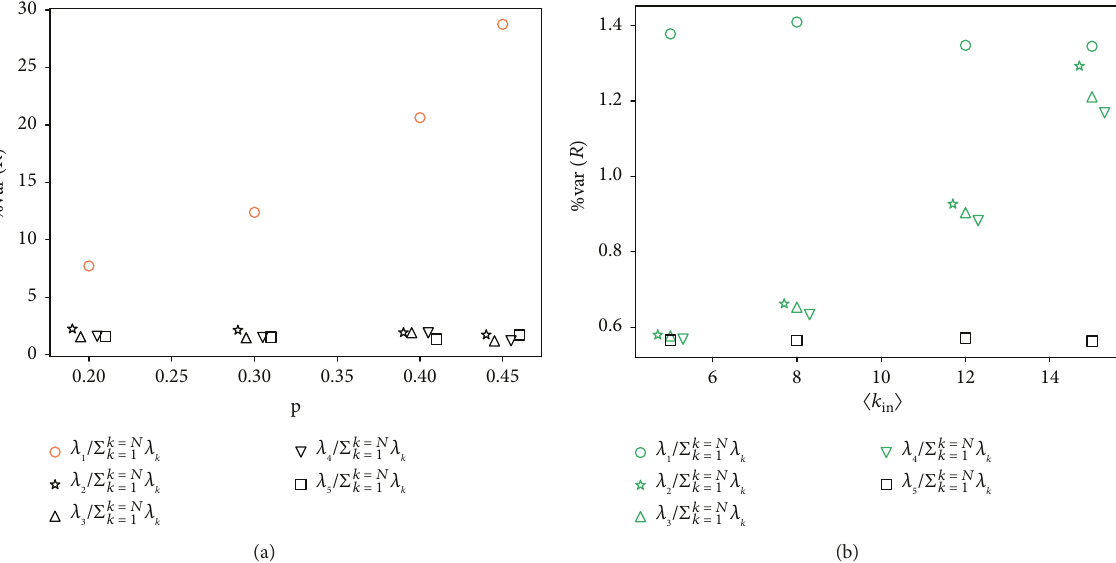
characterized by p , does so, and hence a 1-factor model is being reinforced. Similarly, in the case of a Newman modular network, besides the fi rst eigenvalue, which is always large, second to fourth eigenvalues increase as modularity, charac- terized by k in , does so, in contrast to eigenvalues on further positions, which remain unchanged or smaller.